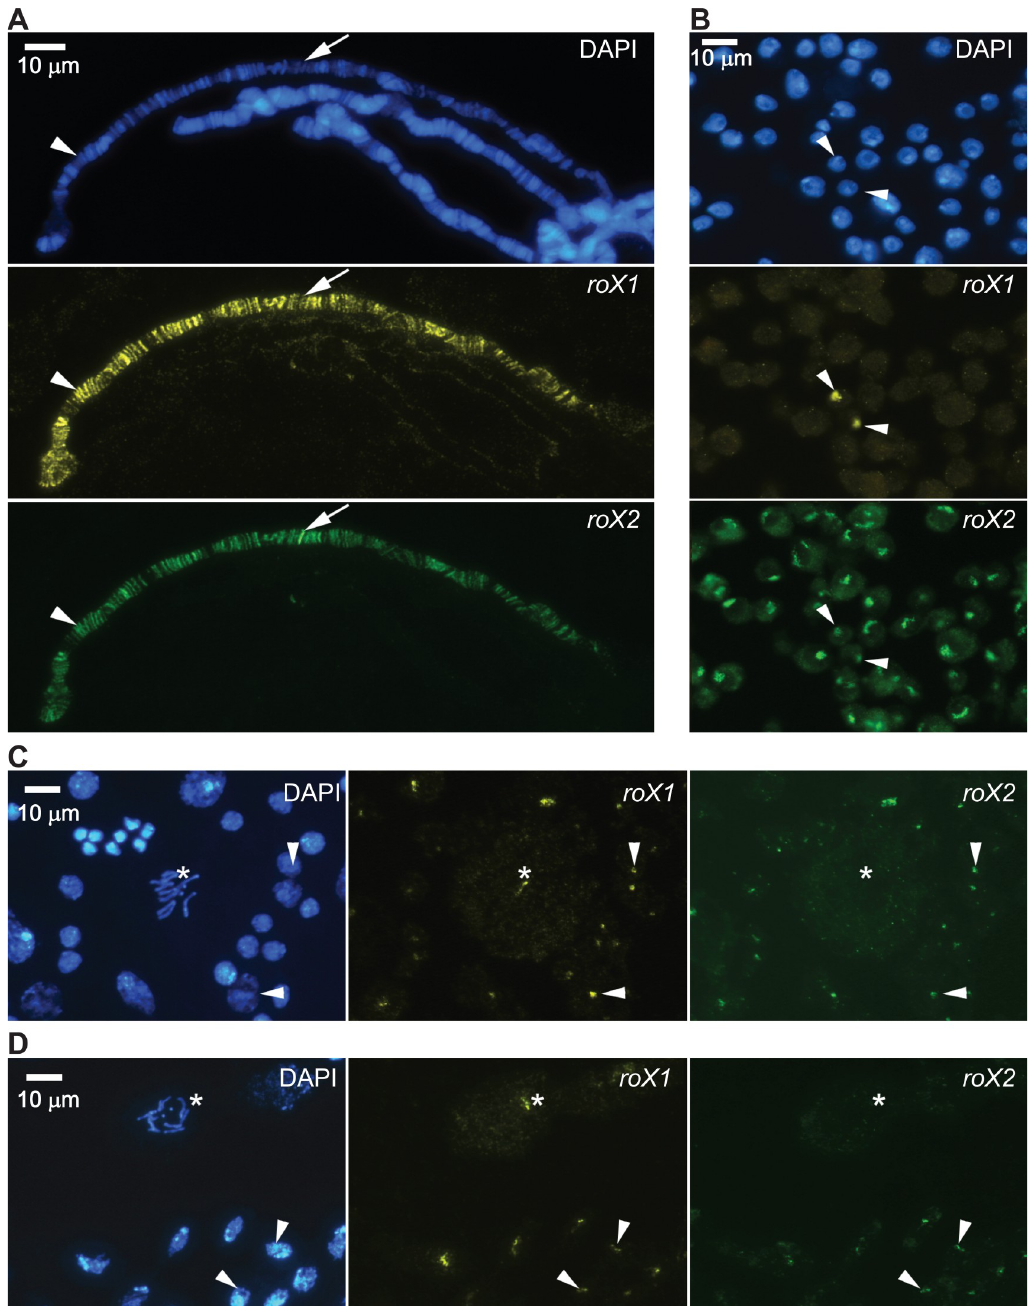
Fig 1. Targeting of roX1 and roX2 RNAs in indicated cell types. Results of RNA in situ hybridization with antisense probes against roX1 (yellow) and roX2 (green), with DAPI staining of DNA (blue). (A) roX1 and roX2 RNA target and colocalize on the X-chromosome in male 3 rd instar larvae salivary glands. The genomic loci of roX1 (arrowhead) and roX2 (arrow) are indicated. (B) roX2 is the dominating roX species in S2 cells. The few cells with localized roX1 domains (arrowheads) also show roX2 targeting. (C, D) On metaphase chromosomes roX1 but not roX2 targets the distal part of the X-chromosome, in male 3 rd instar larvae neuroblasts (C) and in male 6 hour embryos (D) . Examples of interphase nuclei with colocalized roX1 and roX2 are indicated with arrowheads and the metaphase X-chromosome decorated by roX1 is indicated by asterisks. More than 12 brain preparations and > 9 embryos were examined. roX1 was detected on the distal part of the X-chromosome in > 70% of metaphase nuclei in both